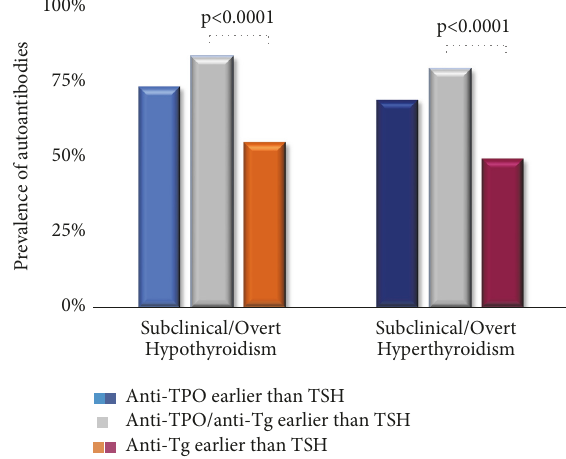
Figure 3: Comparison of the prevalence of anti-TPO (light blue/dark blue), anti-Tg (orange/burgundy) and combined anti- TPO or anti-Tg (grey) in subjects converted to subclinical/overt hypothyroidism (group A1) and hyperthyroidism (group